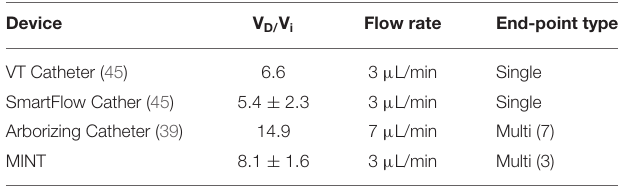
TABLE 1 | Comparison of V D for different single-needle and multi-point CED